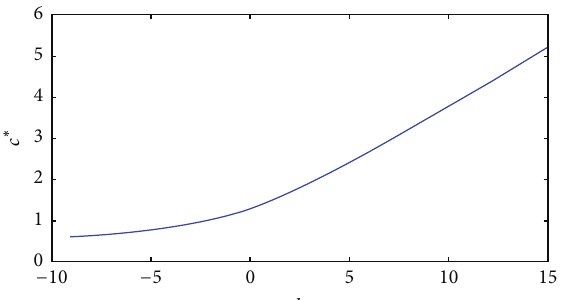
50 10 15−5−10 Figure 20: Plot of how 𝑐 ∗ changes with 𝑘 for ℎ 󸀠 (𝑢) = 𝑢 + 𝑘𝑢 2 . For a comparison, refer to Figure 10, where ℎ 󸀠 (𝑢) = 𝑘𝑢